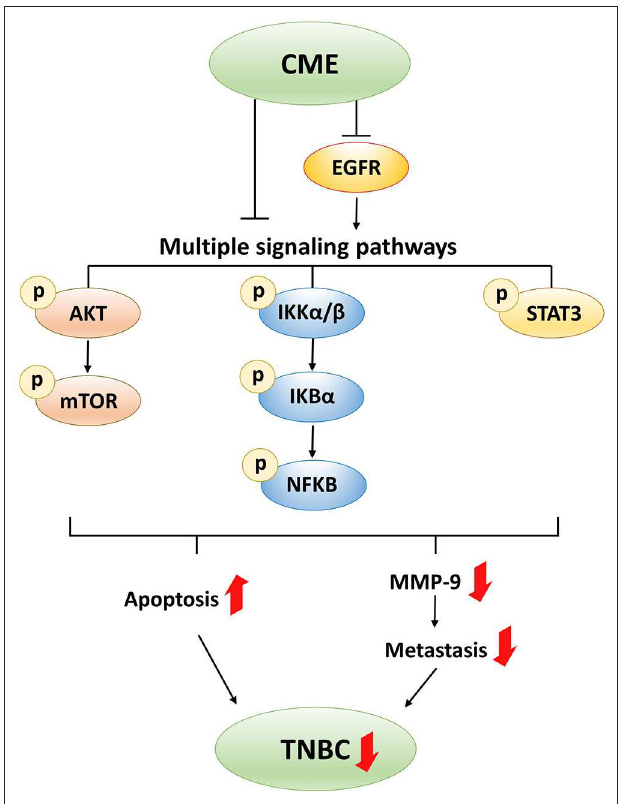
FIGURE 8 | Proposed anti-cancer mechanism of CME in